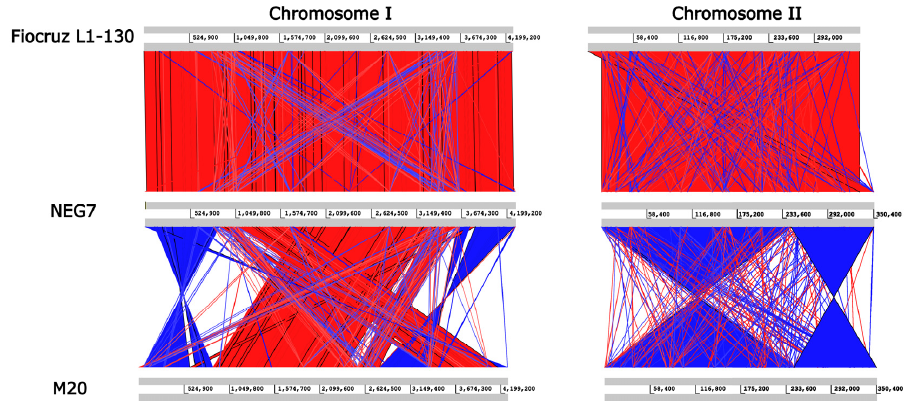
Figure 4. The genome structure rearrangement analysis of the NEG7 strain generated by Artemis comparison tool (ACT), using the genomes of L. interrogans serovar Copenhageni strains Fiocruz L1-130 and M20 as reference. Red bands depict similar regions and blue bands illustrate inversions.